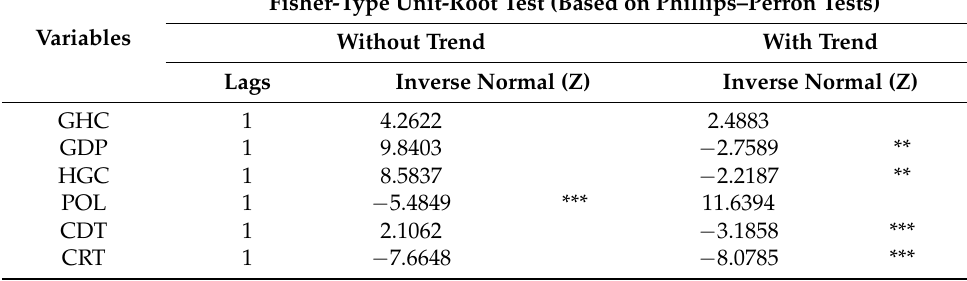
Table 7. Fisher-type unit-root test.